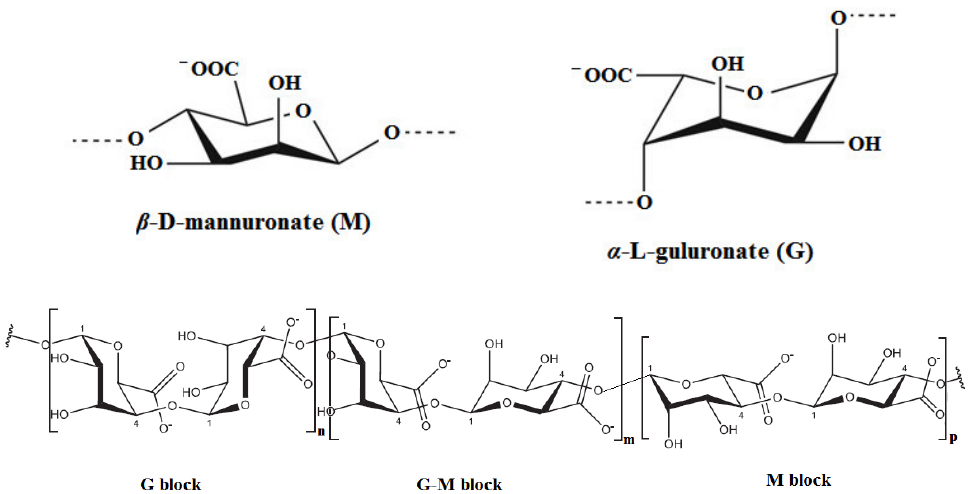
Scheme 6. Alginates mer units and polymer